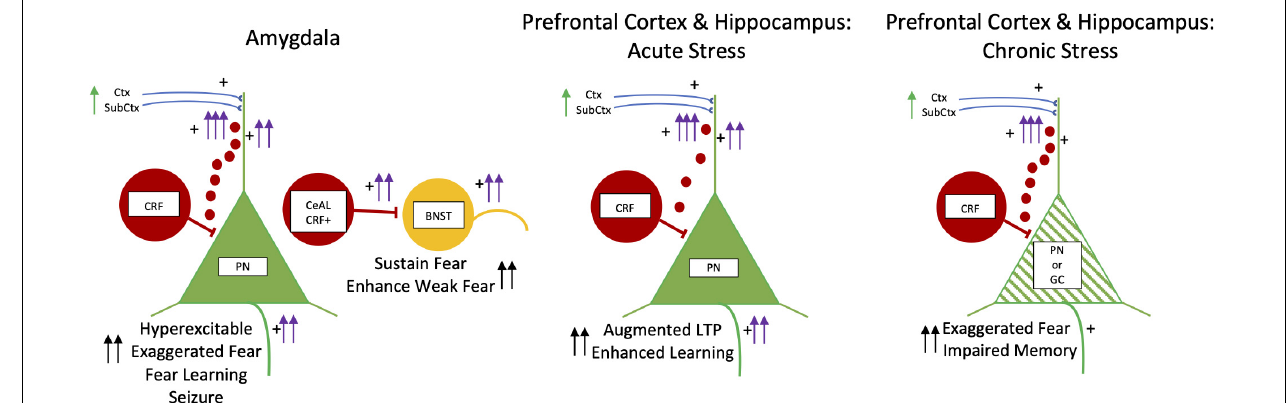
FIGURE 5 | Kindling, Fear, and Acute and Chronic Stress: CRF. CRF neurons are illustrated by red cells and the small red circles depict volume conduction of CRF molecules to dendrites of PN and GC dendrites. BNST is in yellow. PN and GC are in green. The left panel has two schematic drawings of CRF in the basolateral amygdala on the left and the lateral division of central amygdala CRF pathway (CeAL CRF +) projecting to the BNST on the right. CRF is excitatory and infusions induce hyperexcitability in PNs with exaggerated fear, enhanced fear learning, and late onset seizures. In the central amygdala to BNST circuit, CRF is involved in facilitating fear to weak threatening stimuli and sustaining fear long beyond the duration of fear stimuli. In the middle and right panels, the effects CRF in acute and chronic stress in the medial prefrontal cortex and hippocampus are shown. With acute stress CRF enhances learning and augments LTP. With chronic stress, more CRF released in both medial prefrontal cortex and hippocampus. This results in dendritic retraction and loss of spines in principal and granule cells (green hatching) creating exaggerated fear and impaired memory function. Abbreviations are the same as in Figure 2